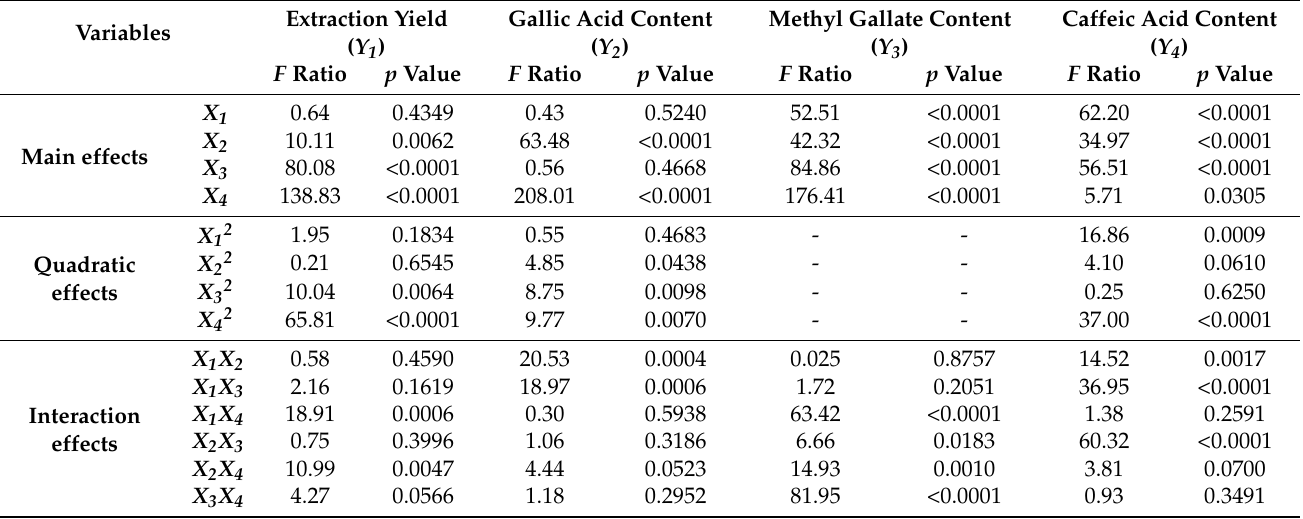
Table 3. F ratio and p value for each independent variable effect in the polynomial response surface models a